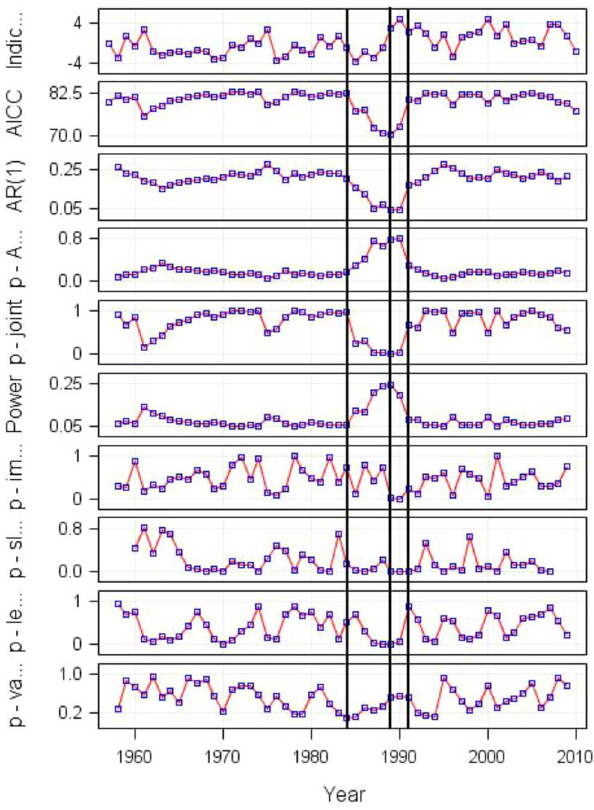
Figure 6. Shiftogram based on PC1 scores derived from all nineteen variables. The vertical lines indicate the position of shift and abbrevations in the Y-axis are from the top: i) plot of the time series analysed (Indic.), ii) quality-of-fit plot (AICC), iii) empirical first order autocorrelation coefficient of the model residuals (AR(1)), iv) p value of the first order autocorrelation coefficient (p-A.), v) joint significance relating all parameters (p-joint), vi) power plot to indicate the risk of false no-warning (Power), vii) statistical test detecting the impulse like shift (p-im.), viii) statistical test detecting the break in slope (p-sl.), ix) statistical test detecting identical levels before and after the shock (p- le.), and x) statistical test detecting the variance before and after the shift (p-var.). For details please see the material and method section ‘ Constructing a shiftogram ’ or [24]